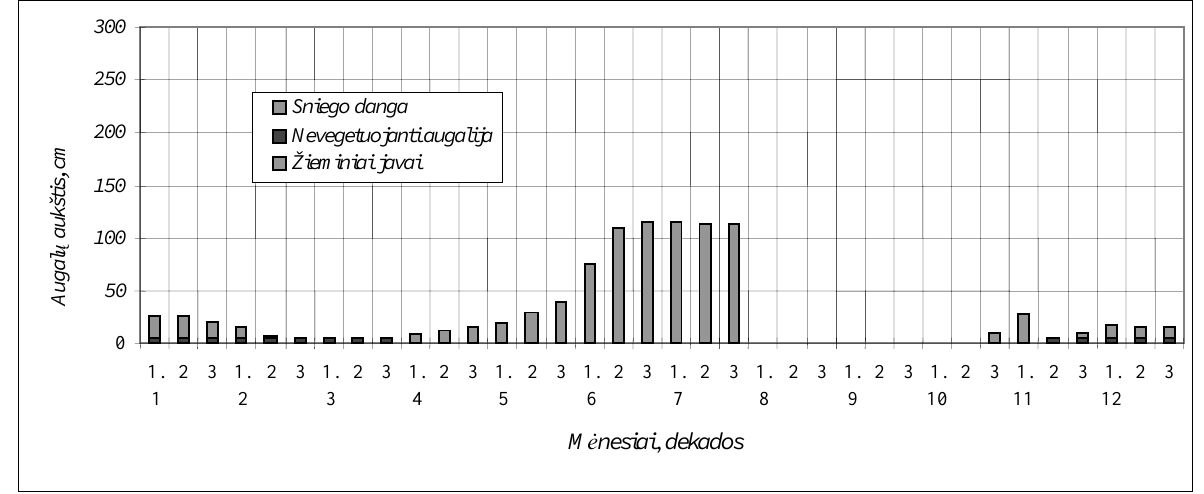
Fig 2 . Vegetation height in a field of the winter